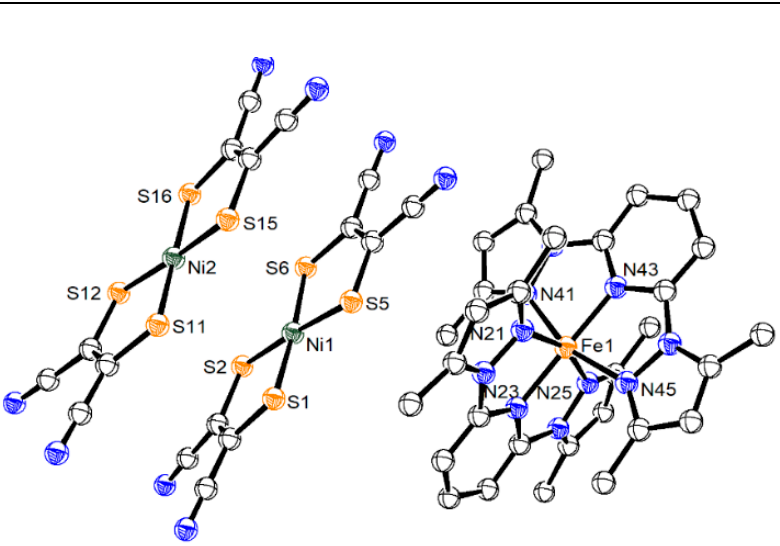
Figure 1. The molecular structure of compound 1 at 100 K, in the ORTEP [29] style with 50% thermal ellipsoids and atom numbering scheme. H atoms have been omitted for clarity.